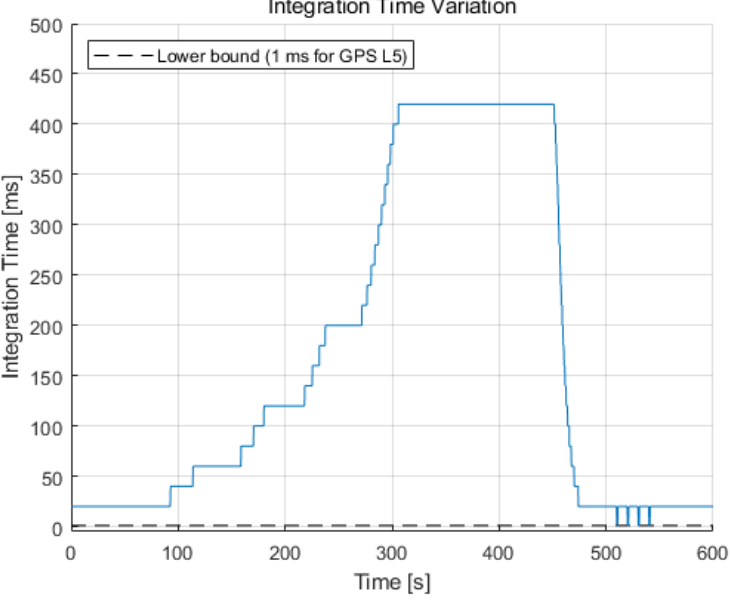
Figure 11. Integration time variation during the simulation varied with a step of Δ𝑇 (20 ms for this study). It increases to 420 ms for the C/N 0 of 5.4 dB-Hz and reduces to the lower bound value in the high dynamics region.